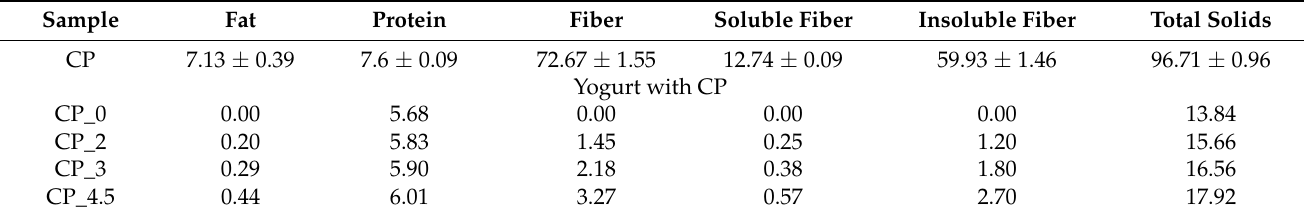
Table 1. Chemical composition (g/100 g) of cranberry pomace (CP) and yogurt made with different amounts of